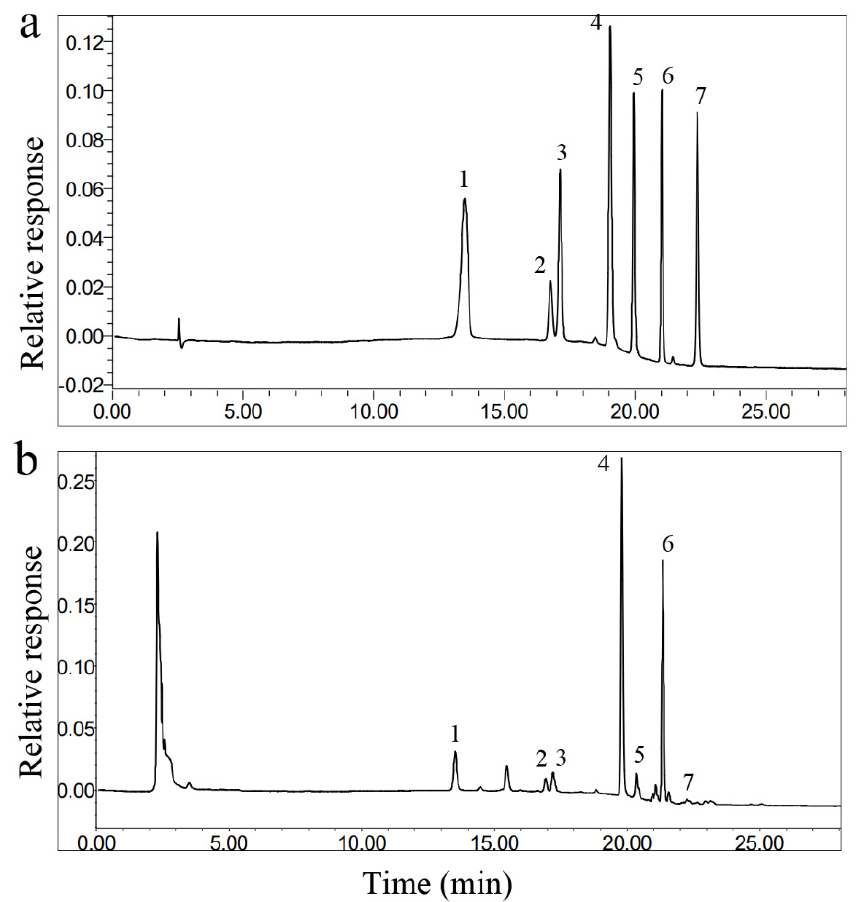
Figure 6. The typical HPLC chromatograms: ( a ) 7 coumarin reference standards and ( b ) A. dahurica sample (1. xanthotoxol, 13.48 min; 2. psoralen, 16.76 min; 3. byakangelicin, 17.13 min; 4. bergapten, 19.04 min; 5. oxypeucedanin, 19.95 min; 6. imperatorin, 21.02 min; and 7. isoimperatorin, 22.38 min) and separation degree of chromatographic peak: 5.86%, 1.27%, 4.17%, 1.87%, 3.36%, 1.82%. Table 2. Validation of linear regression equation, linear range, precision, repeatability, and stability of 7